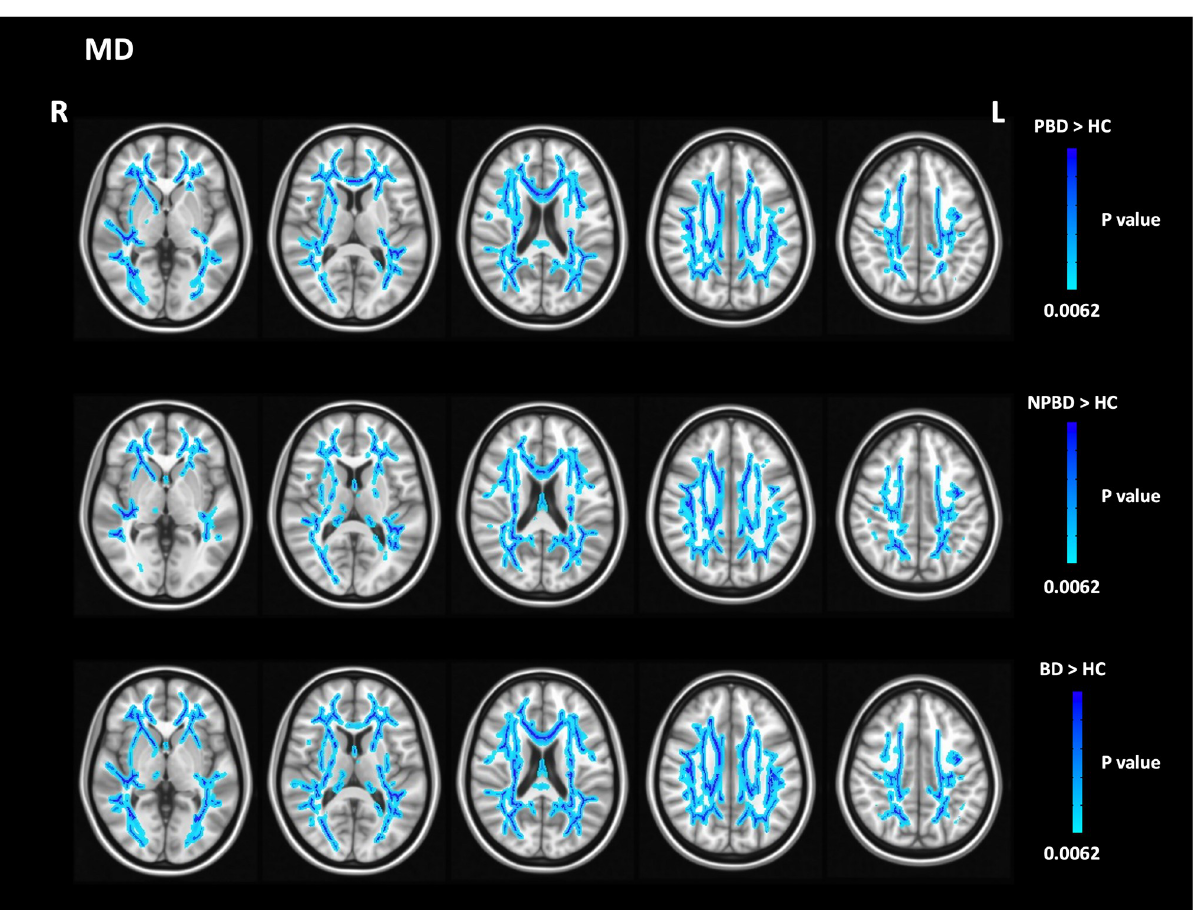
Fig 2. Tract-based spatial statistics analyses identified white matter areas affected by a significant increase in mean diffusivity (MD) in patients with psychotic bipolar disorder (PBD) (N = 29), non-psychotic bipolar disorder (NPBD) (N = 23), and bipolar disorder (BD) (N = 52) in comparisons with healthy controls (HCs) (N = 65). Family-wise error corrected P < 0.0062.